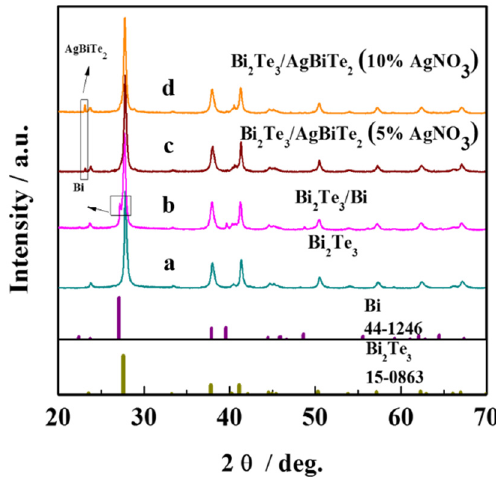
Figure 1. XRD patterns of the products prepared at 180 °C for 6 h ( a ) pure Bi 2 Te 3 , ( b ) Bi 2 Te 3 /Bi core-shell, ( c ) Bi 2 Te 3 /AgBiTe 2 heterostructure (5% AgNO 3 ), and ( d ) Bi 2 Te 3 /AgBiTe 2 heterostructure (10% AgNO 3 ).